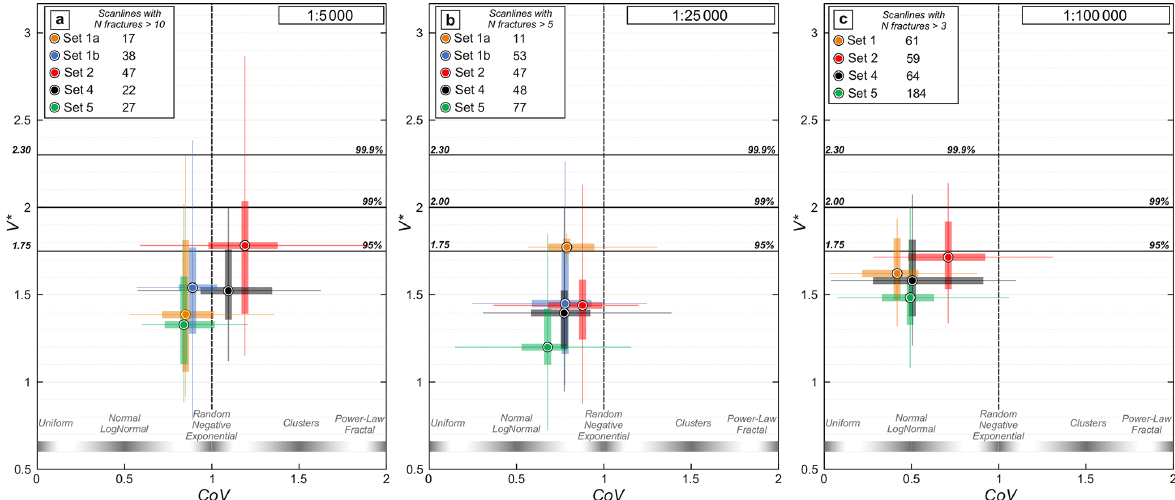
Figure 8. Box-and-whisker plots reporting CoV– V ∗ values quantifying the spatial organization of the orientation sets identified in the lineament map at (a) 1 : 5000, (b) 1 : 25000, and (c) 1 : 100000